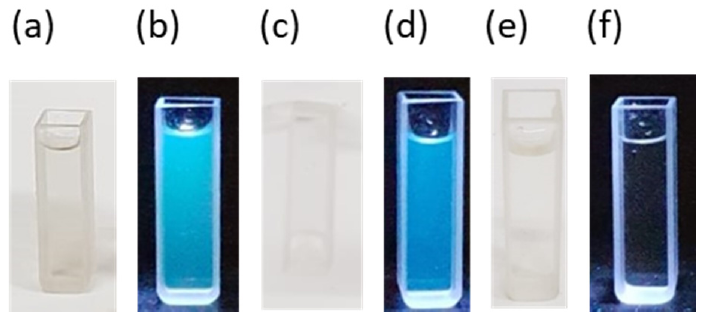
Figure 6. Images of aqueous suspensions of samples GQD_125 (parts ( a ) and ( b )) and GQD_175 (parts ( c ) and ( d )); and sample GO_Ref (parts ( e ) and ( f )). The pictures shown in parts ( a ), ( c ) and ( e ) were recorded under white light; whereas the ones in parts ( b ), ( d ) and ( f ) were recorded under UV light.